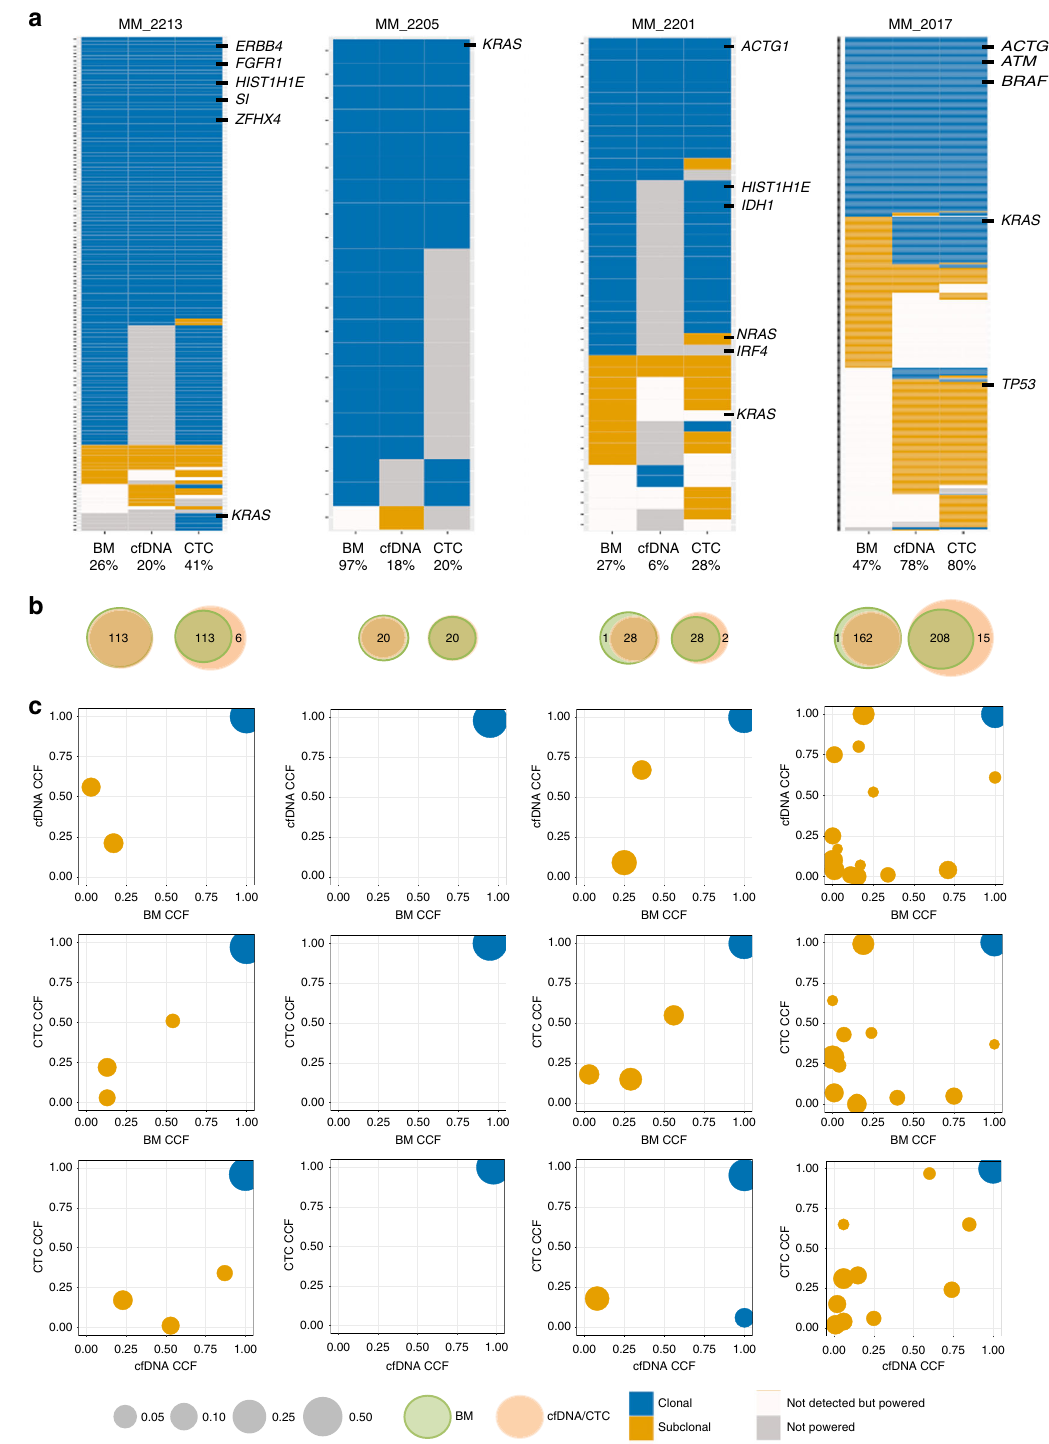
Fig. 5 Whole-exome sequencing of matched cfDNA, CTCs, and BM tumor samples. a Presence of clonal (navyblue) and subclonal (yellow) somatic mutations in BM, cfDNA, and CTC WES is shown. Snow color represents mutations that were not detected with ≥ 0.9 detection power and gray color represents mutation sites with <0.9 detection power. MM and actionable pan-cancer related genes and purity of each sample are indicated. b Left Venn diagram shows the number of clonal mutations that were present in bone marrow biopsies (green) and con fi rmed in either cfDNA or CTC samples (orange). Right Venn diagram shows the number of clonal mutations that were present in either cfDNA or CTC samples (orange) and con fi rmed in bone marrow biopsies (green). c Cancer cell fraction (CCF) for clusters of SSNVs detected in bone marrow, cfDNA, and CTC samples from the same MM patient. Mutations were clustered by CCF for each pair of samples using PHYLOGIC. Clonal (navyblue) SSNVs were de fi ned as events having ≥ 0.9 CCF in both samples. Subclonal (yellow) SSNVs were de fi ned as events having <0.9 CCF in samples. Size of circles indicated the fraction of SSNVs. Mutations having ≥ 0.9 detection power in both samples are shown and clusters with <3 mutations are